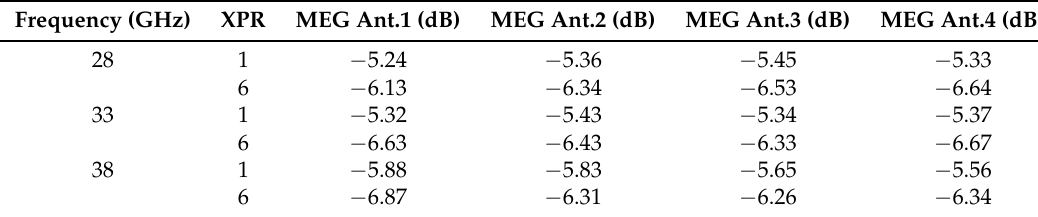
Table 2. MEG for Antenna-1 to